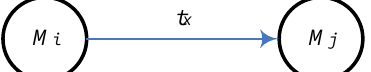
Figure 3. Generated reachability graph of Petri net model shown in Figure 2.